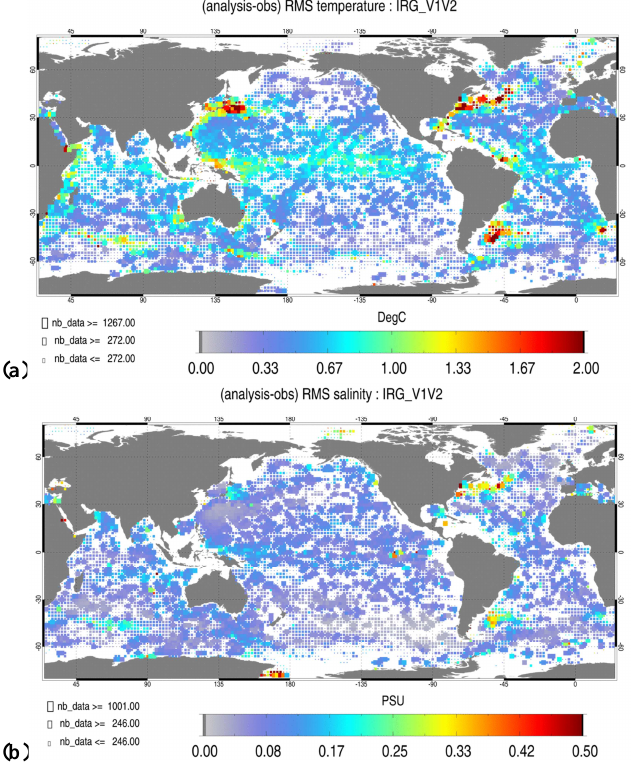
Fig. 6. 2010 temperature (a) and salinity (b) RMS of the differences between all available observations from the CORIOLIS database and daily mean analyses for the IRG V1V2 system. Averages are performed in the 0–500m layer. The size of the pixel is proportional to the number of observations used to compute the RMS in 2 ◦ × 2 ◦ boxes. Observations that differ by more than 8 °C or 1 psu of a climatological reference are not taken into account when calculating the diagnostic.